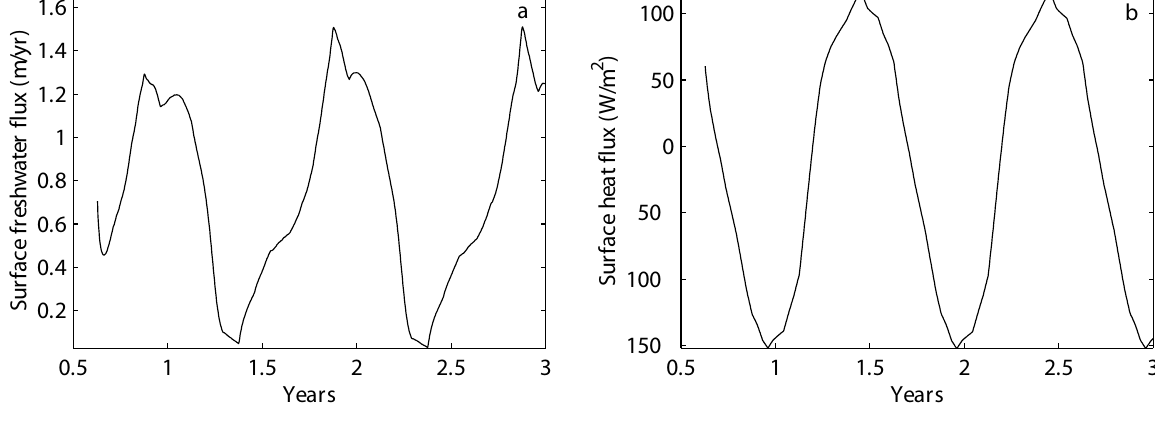
Fig. 10. Basin averaged time series of (a) diagnosed surface freshwater flux and (b) diagnosed surface total heat flux, corresponding to ALERMO’s climatological